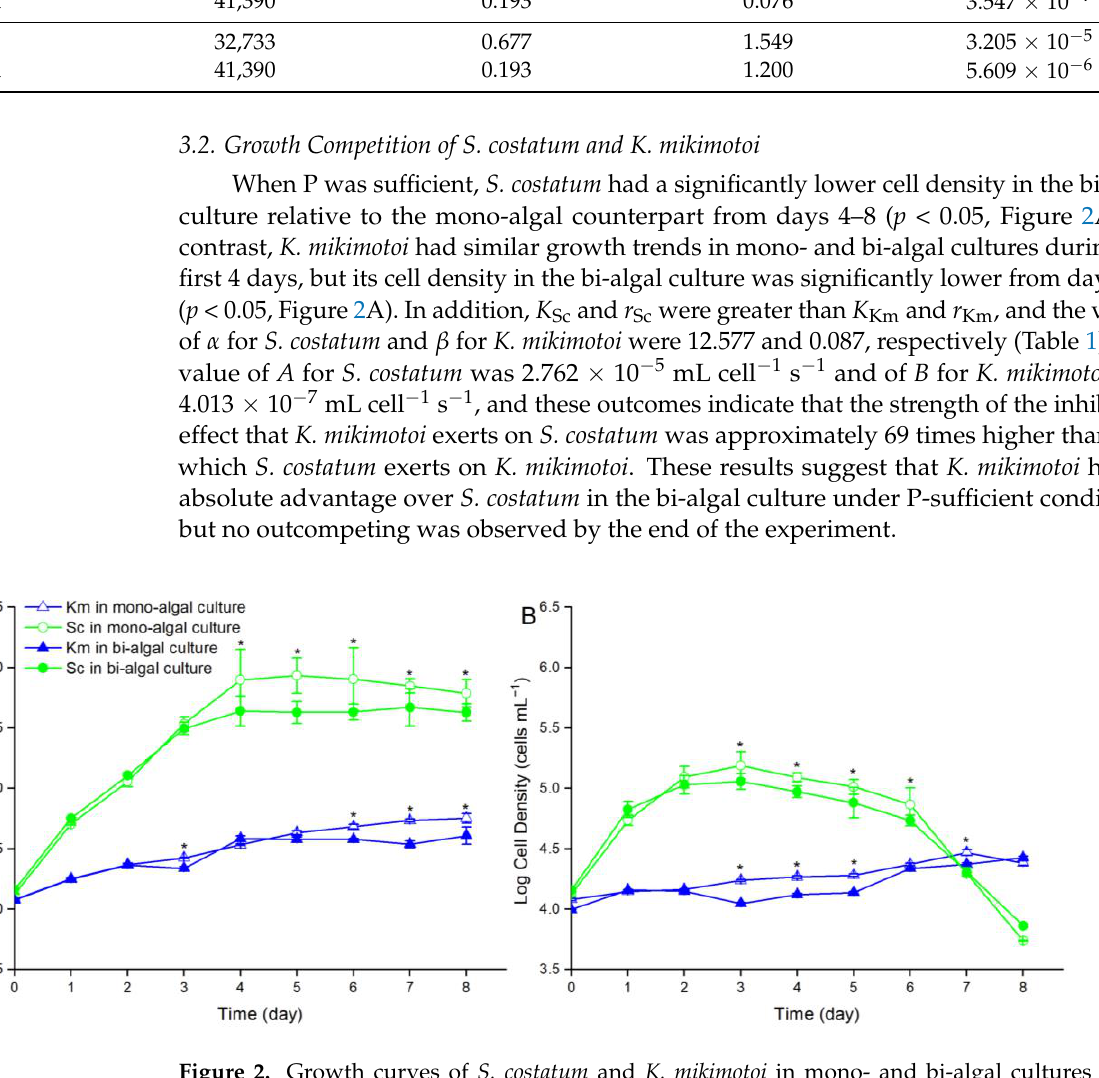
Figure 2. Growth curves of S. costatum and K. mikimotoi in mono- and bi-algal cultures under P-sufficient ( A )/deficient ( B ) conditions. The values are the mean ± S.D. ( n = 3), with * represent significant differences ( p < 0.05) between mono-algal and bi-algal